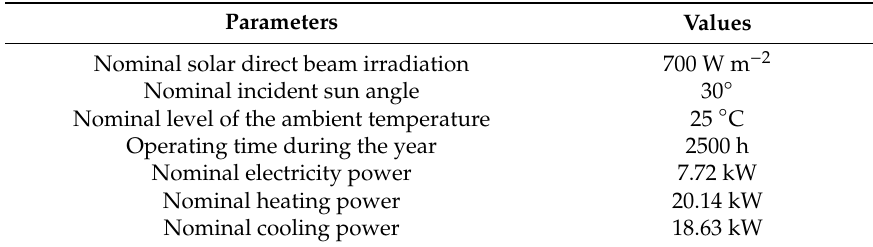
Table 3. Economic input data of the present paper [36,41].